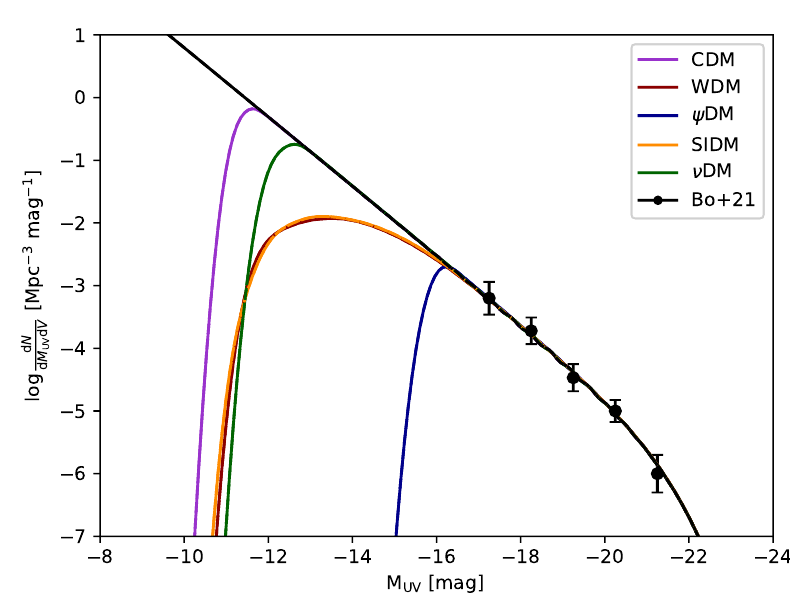
Figure 15. Predicted ultra-faint end of the UV luminosity function at z ∼ 10 in different DM scenarios: CDM (magenta), WDM (red), ψ DM (green), SIDM (orange), and ν DM (green). Data for M UV (cid:46) − 17 by [70,71] are also illustrated for reference (black